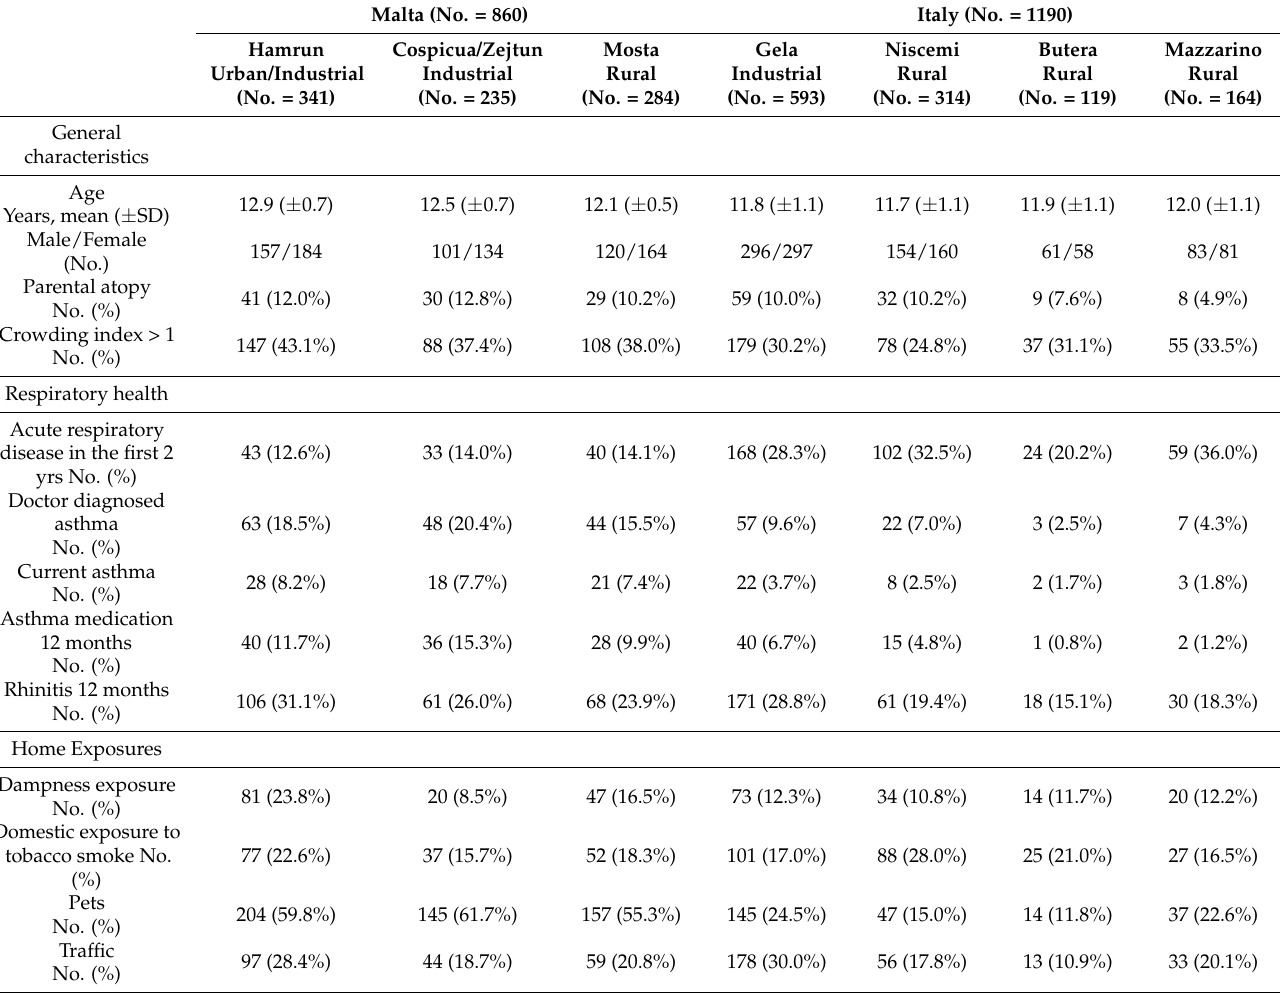
Table 1. Characteristics of the study sample (total no. = 2050). The characteristics of each community (urban, rural, industrial) are also indicated. Malta (No. =